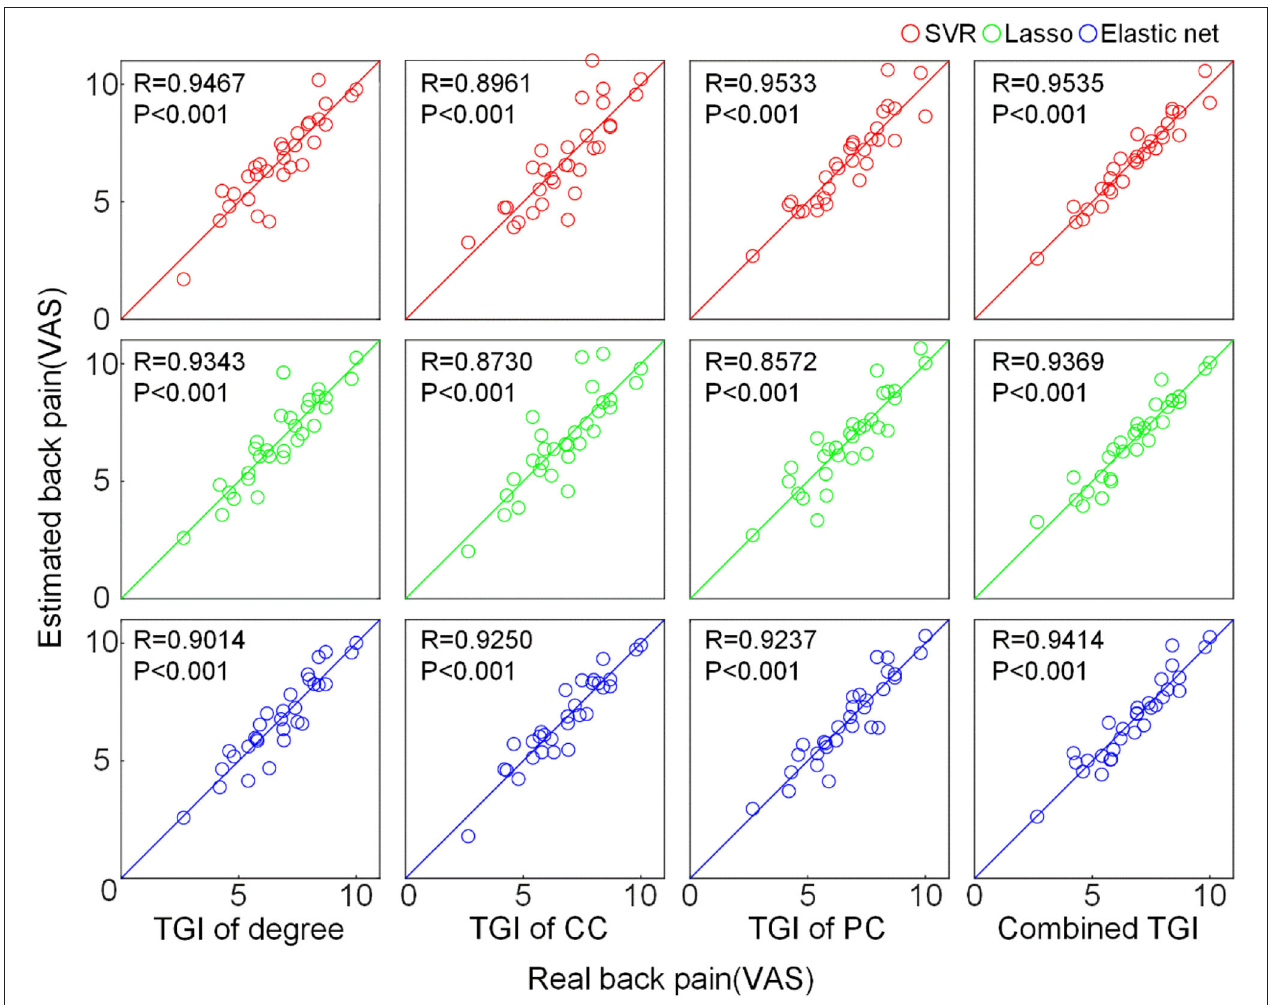
FIGURE 3 | Prediction performance of pain intensity using the TGI of different network properties. The scatter plot shows the correlation between the real VAS score and the predicted VAS score estimated by different features through different regression models. The solid lines indicate the identity line (y = x). CC, clustering coefficient; PC, participation coefficient; VAS, visual analog